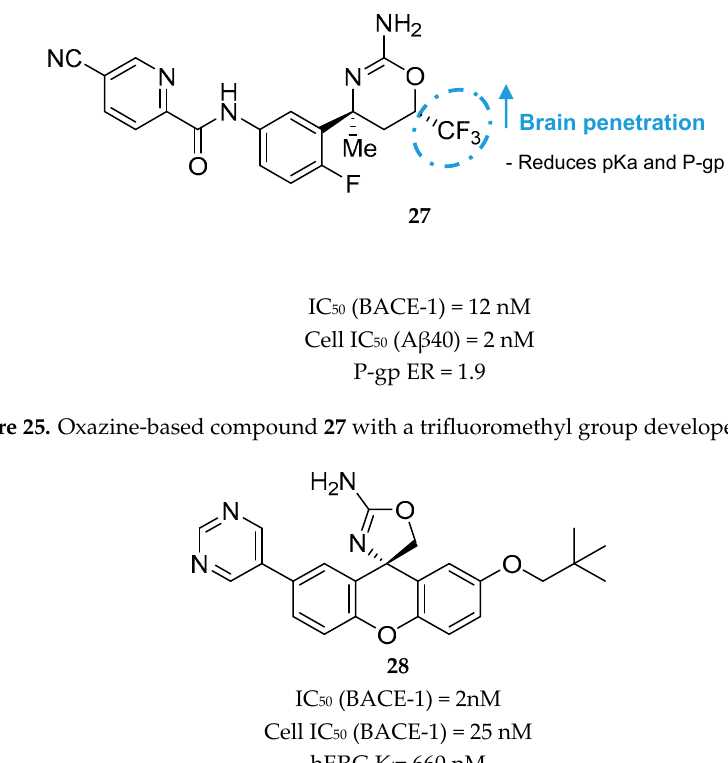
Figure 24. SAR of optimized inhibitor 26 developed by Roche.